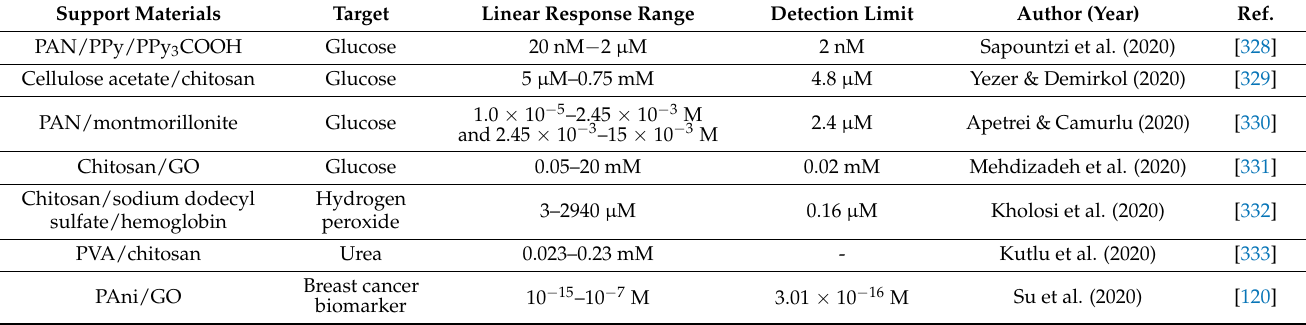
Table 7. Polymeric nanofibers utilized for modification of the electrochemical sensors.